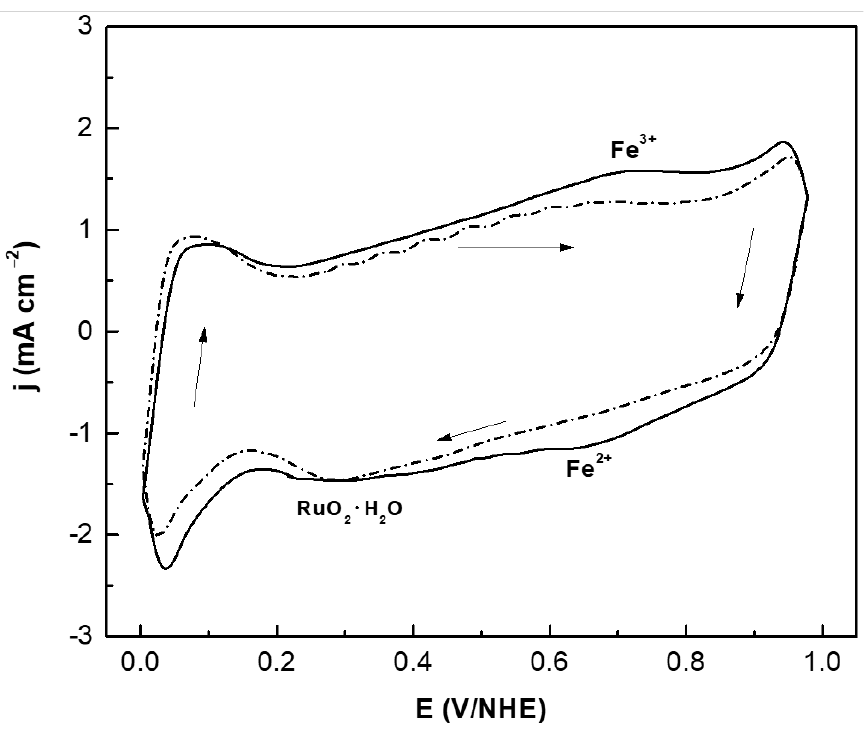
Figure 4. Cyclic voltammograms of CoFeRu/C without (solid line) and with (dash line) 2 mol L − 1 methanol. The sweep rate was 20 mV s − 1 and as electrolyte 0.5 mol L − 1 H 2 SO 4 .